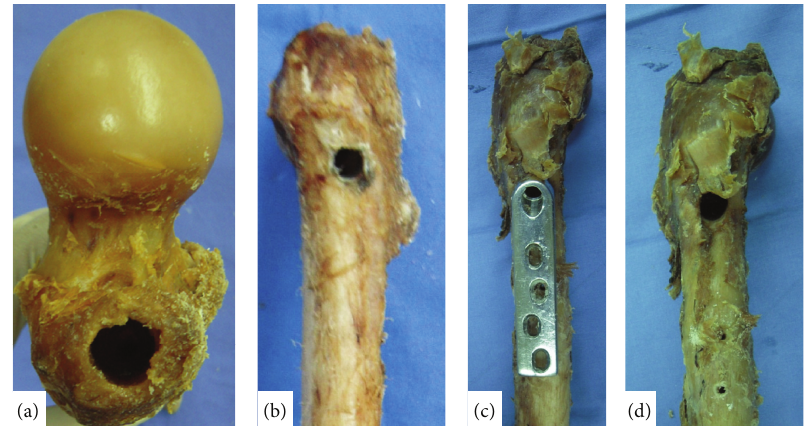
Figure 1: (a) An opening was created on the tip of the greater trochanter following removal of the PFNA-II (16.5 mm). (b) An opening was created on the lateral wall of the proximal femur following removal of the PFNA-II. (c) DHS position on the proximal femur. (d) An opening was created on the lateral wall of the proximal femur following removal of the DHS (12.5